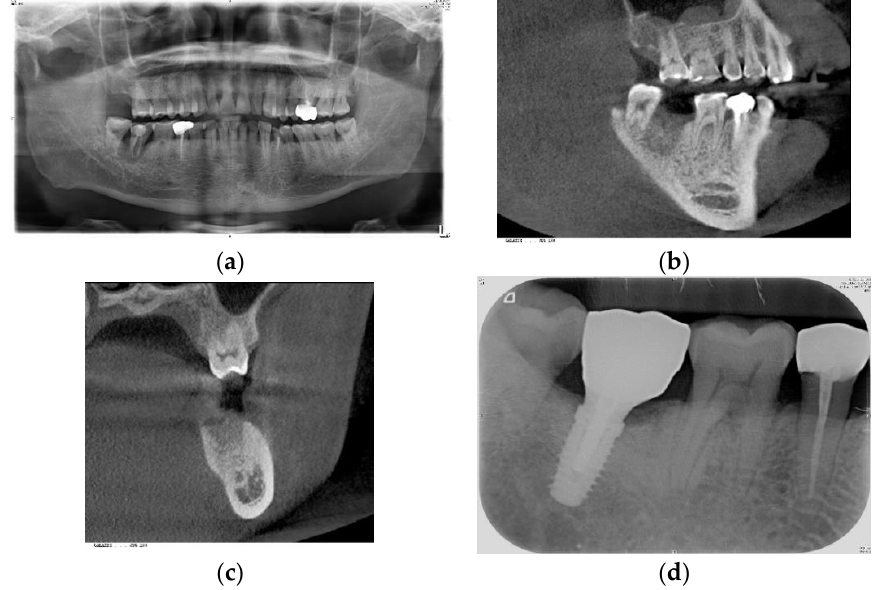
Figure 2. Implant site development of 49-year-old male patient using porcine bone and porcine collagen membrane: ( a ) severe bone loss on right-mandible second molar due to root fracture; ( b ) result 3 months after ridge augmentation (five months post-extraction) shown in cone beam computed tomography (CBCT; sagittal view); ( c ) CBCT (frontal views); and ( d ) follow-up after prosthetic